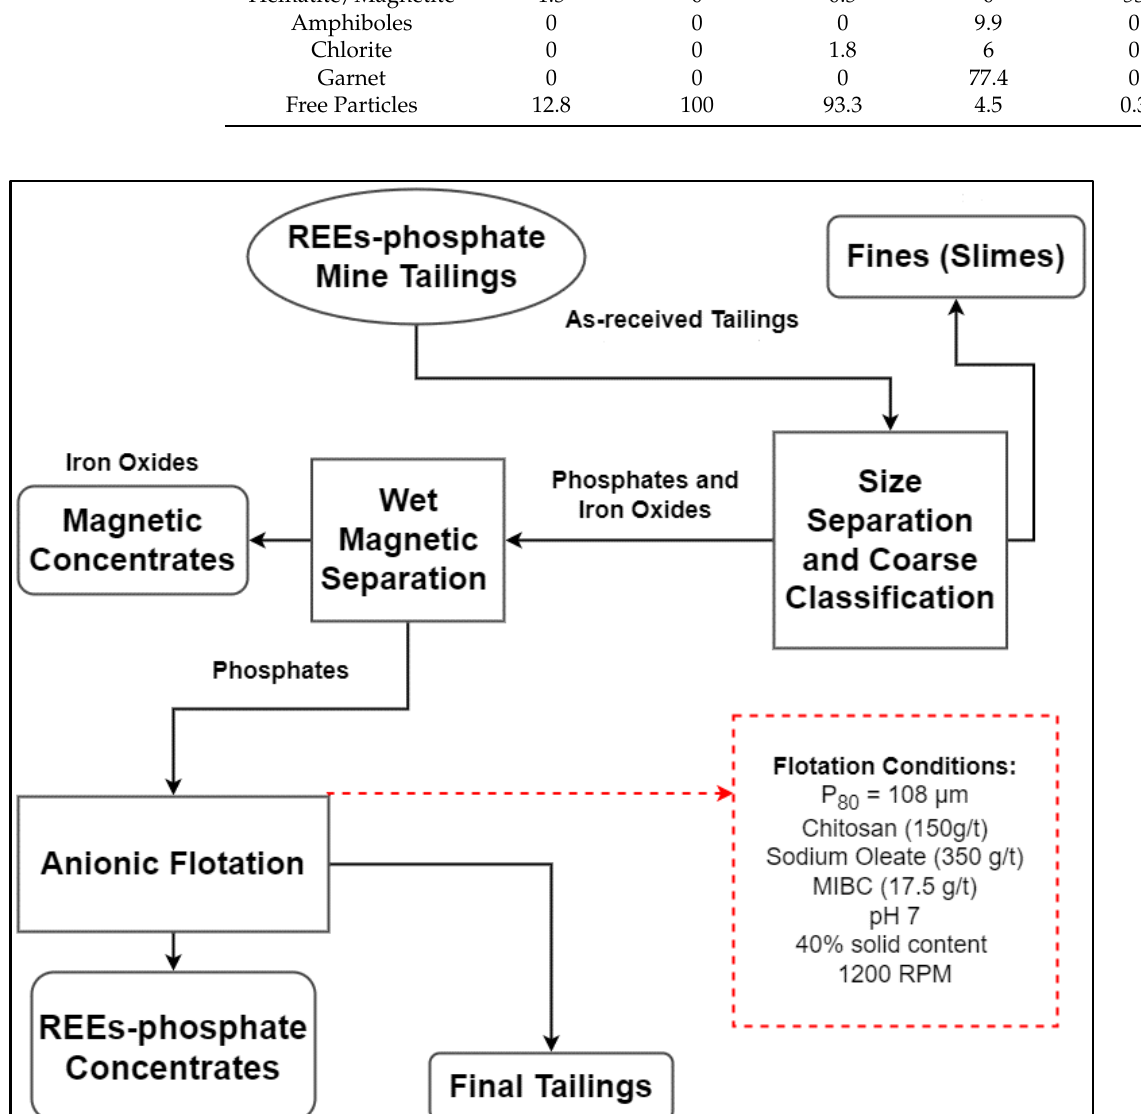
Figure 7. Proposed flotation flowsheet for the enrichment of REE-bearing phosphates in